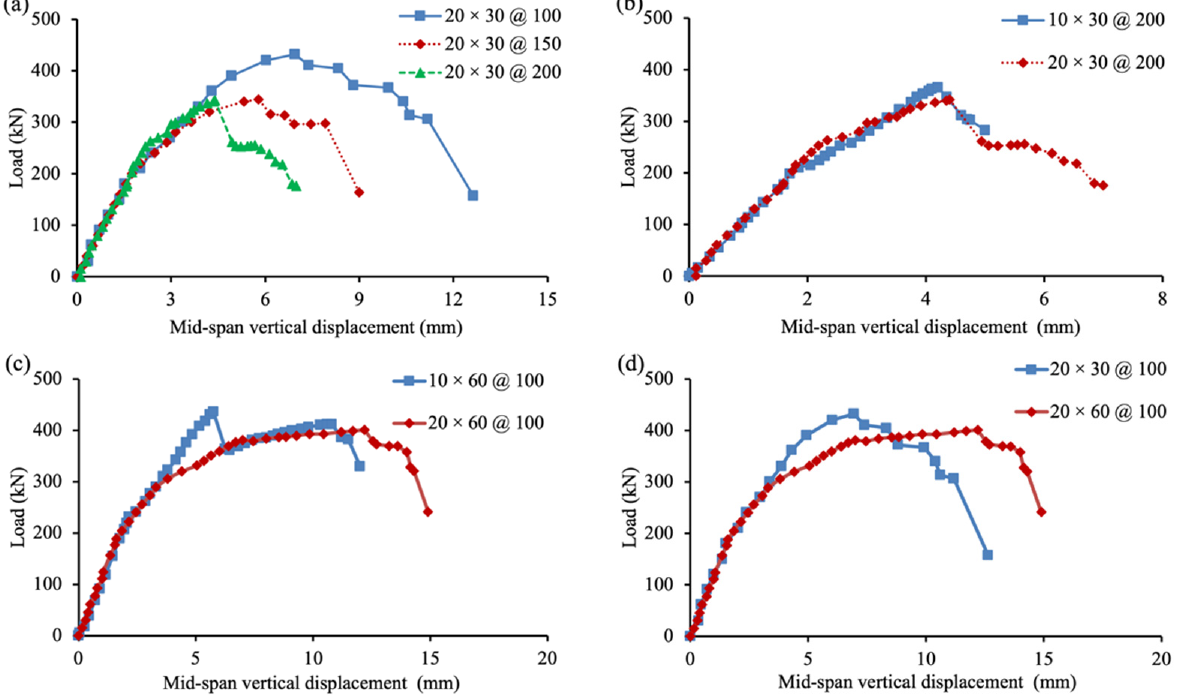
Figure 7. Load–vertical displacement relation. ( a ) Spacing comparison; ( b ) Tickness comparison; ( c ) Tickness comparison; ( d ) Width comparison .